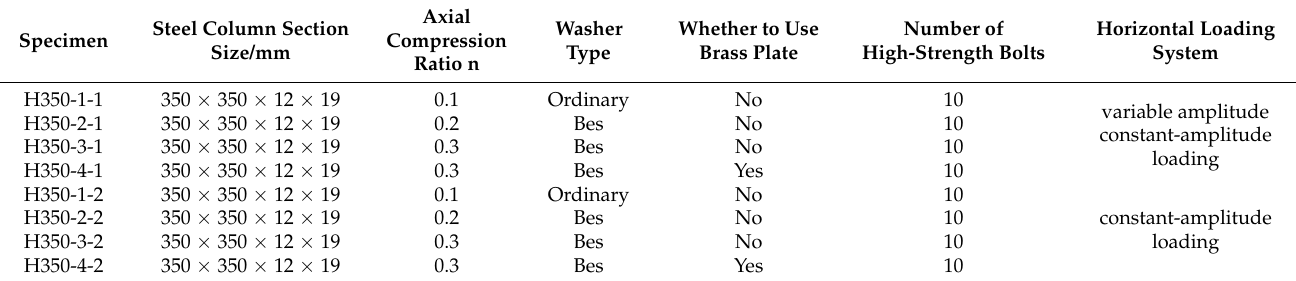
Table 1. Parameters of the specimens.